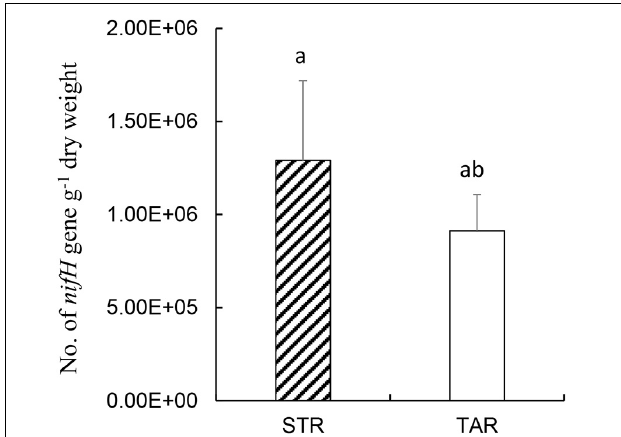
FIGURE 5 | Numbers of nifH gene copies based on cDNA in the root samples from STR and TAR plants during July in the wetlands. Bars represent standard errors ( n = 3). Bars with different letters (a, ab) are not significantly different ( p < 0.05) according to Tukey’s test for pairwise mean comparison at α = 0.05. STR, Scirpus triqueter roots. TAR, Typha angustifolia